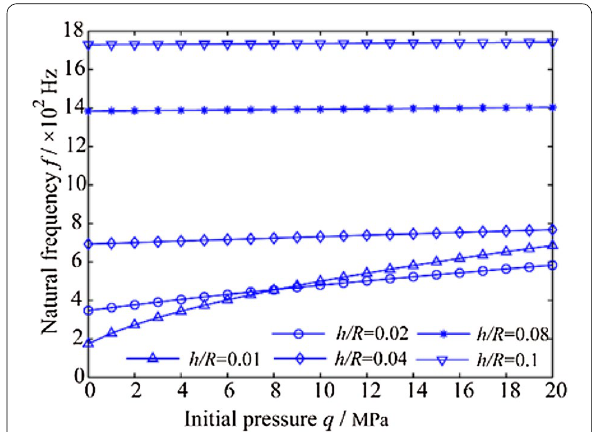
Figure 3 Variation of the natural frequency against q for several special values of h / R